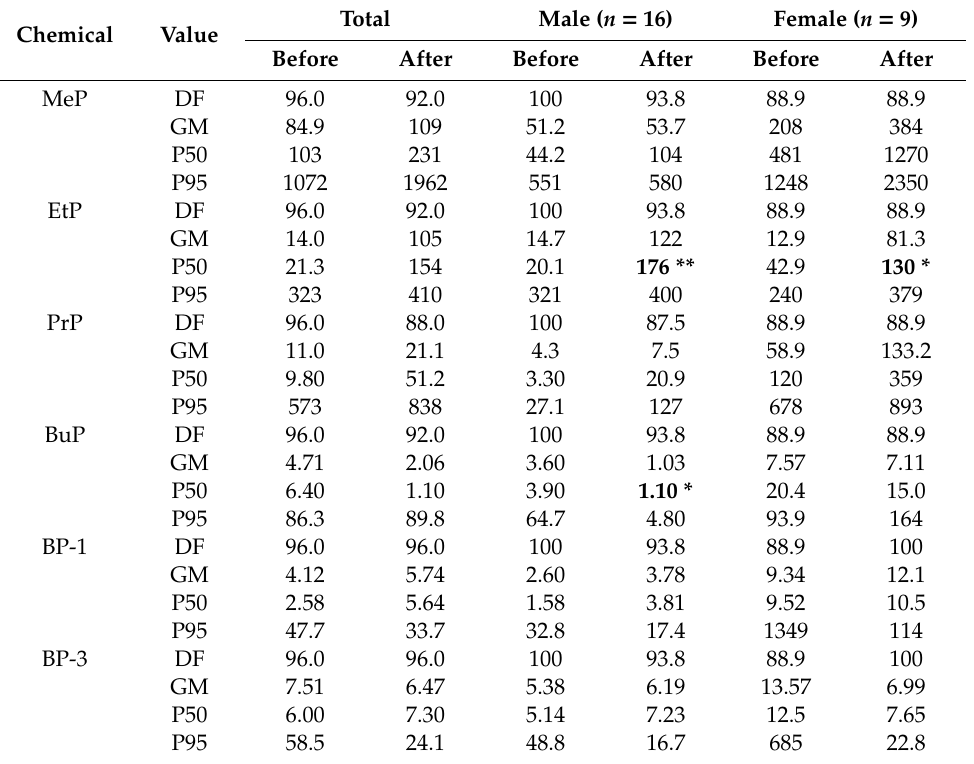
Table 1. Concentrations ( µ g / L) and detection frequency of methyl-, ethyl-, propyl-, and butylparaben; benzophenone-1; and benzophenone-3 in urine samples of the participants ( n = 25) before and after the temple